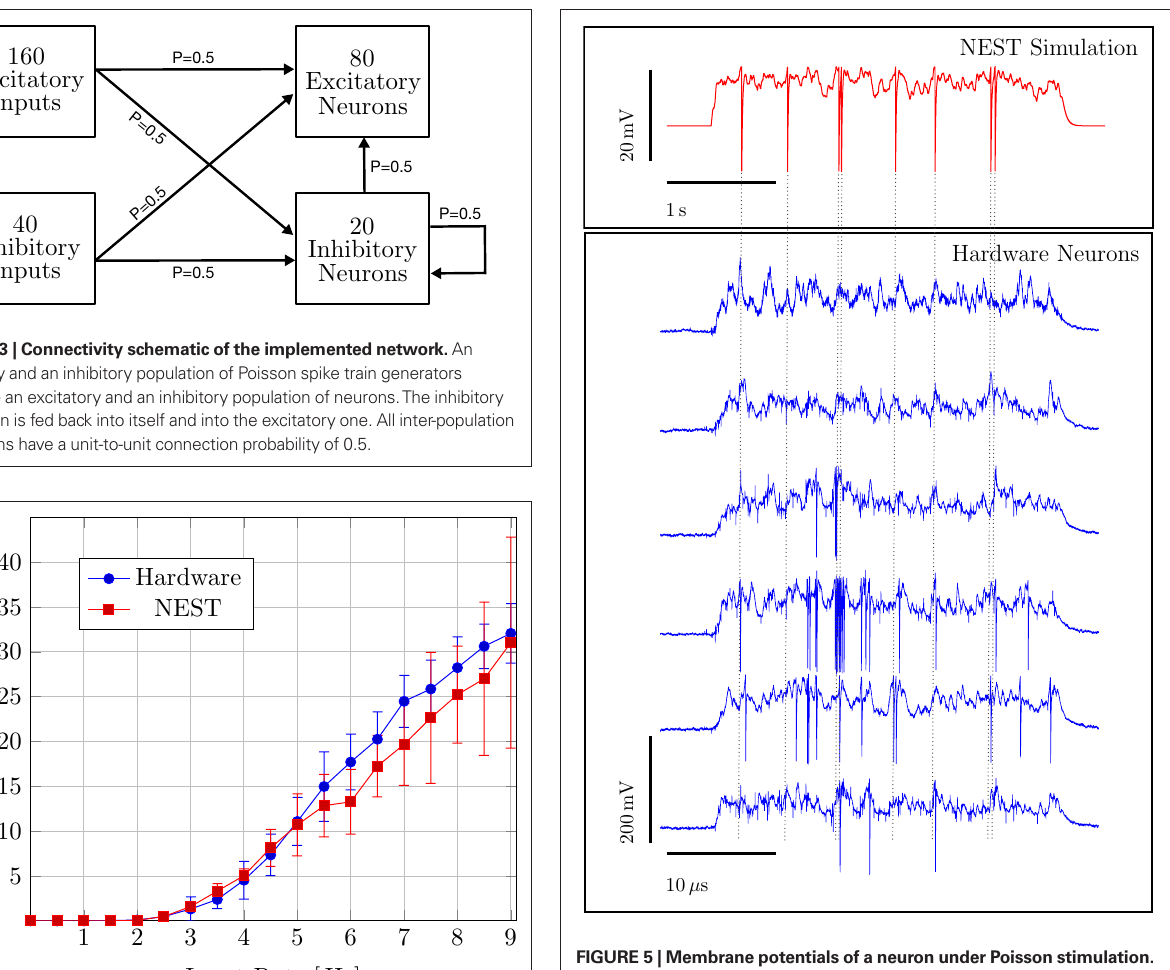
FIGURE 5 | Membrane potentials of a neuron under Poisson stimulation. Input spike times are identical for all traces. The uppermost trace (red) represents a NEST simulation. Spike times determined by NEST are marked with dashed vertical lines in light gray. The lower six traces (blue) represent measurements from adjacent hardware neurons recorded in separate runs. For the hardware traces, the given time and voltage scales indicate the real physical dimensions of the emulation.